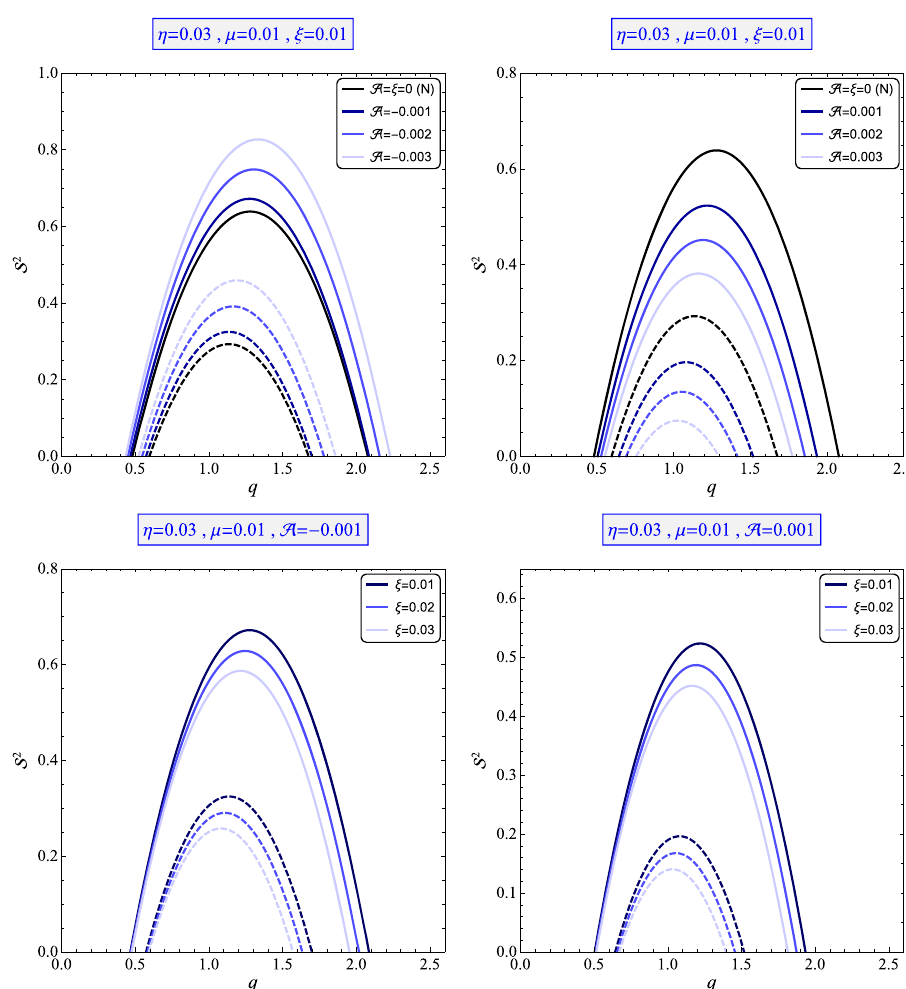
Fig. 3 Growth rate of small perturbations in the fluid disk in the context of EMSG. It is worth mentioning that, in all panels of growth rate figures, the solid (dashed) curves show y = 1 ( y = 3) and we have assumed, Γ =